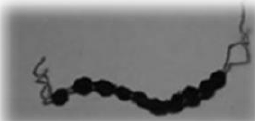
Figure 1. Image of device for multi-spheres adsorptive microextraction coated with several commercial activated carbons (MSAµE(AC)) used in the present work.